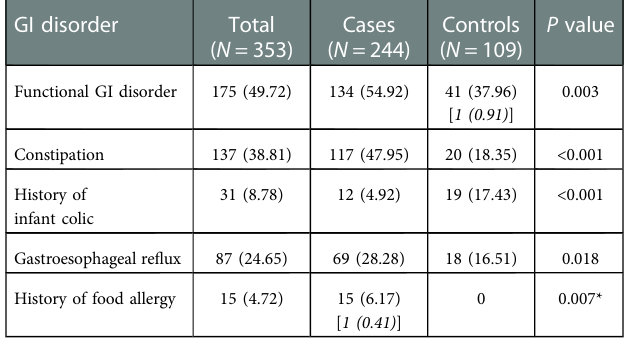
TABLE 4 Prevalence of functional gastrointestinal disorders. Data represents number (%) of patients with stated characteristics. GI,